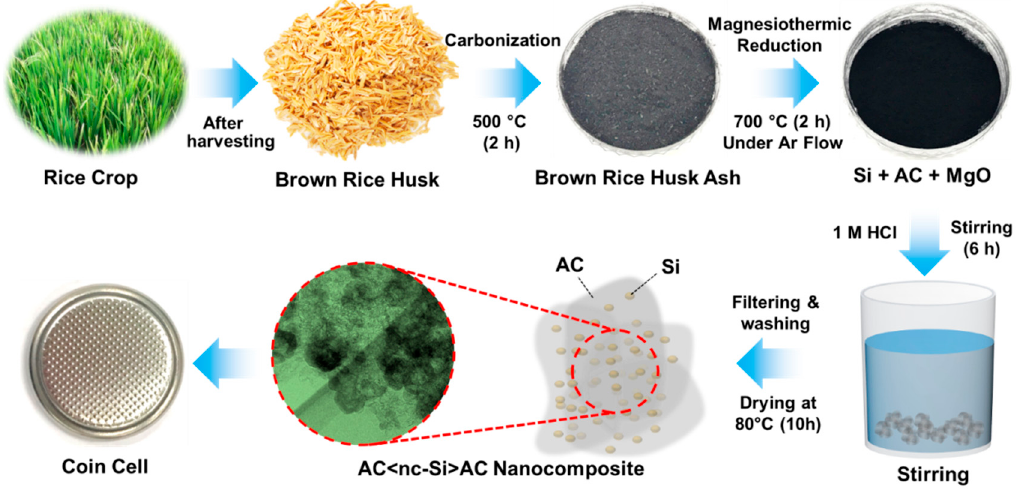
Figure 1. Experimental procedures for the synchronous derivation of activated-carbon-decorated silicon nanocrystal (AC<nc-Si>AC) nanocomposites from the biomass resource of brown rice husks